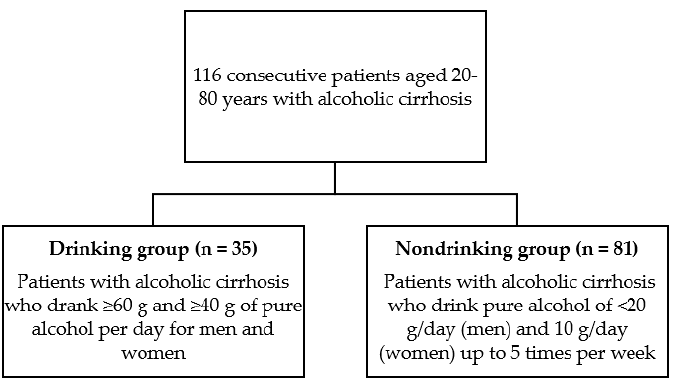
Figure 1. Flow chart of patient enrollment in the study.